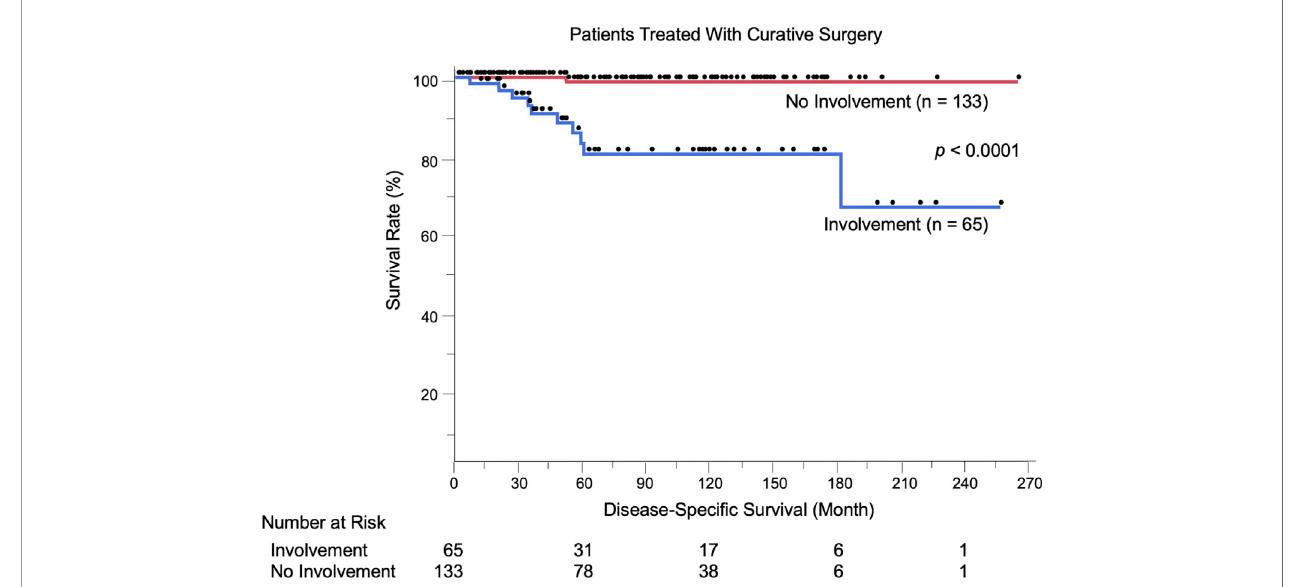
FIGURE 2 | Kaplan-Meier disease-speci fi c survival curves of the 198 patients treated with curative surgery strati fi ed by boundary area involvement. Patients with EMPD lesions in boundary areas had signi fi cantly shortened their survival ( p < 0.0001). The number at risk is also shown.